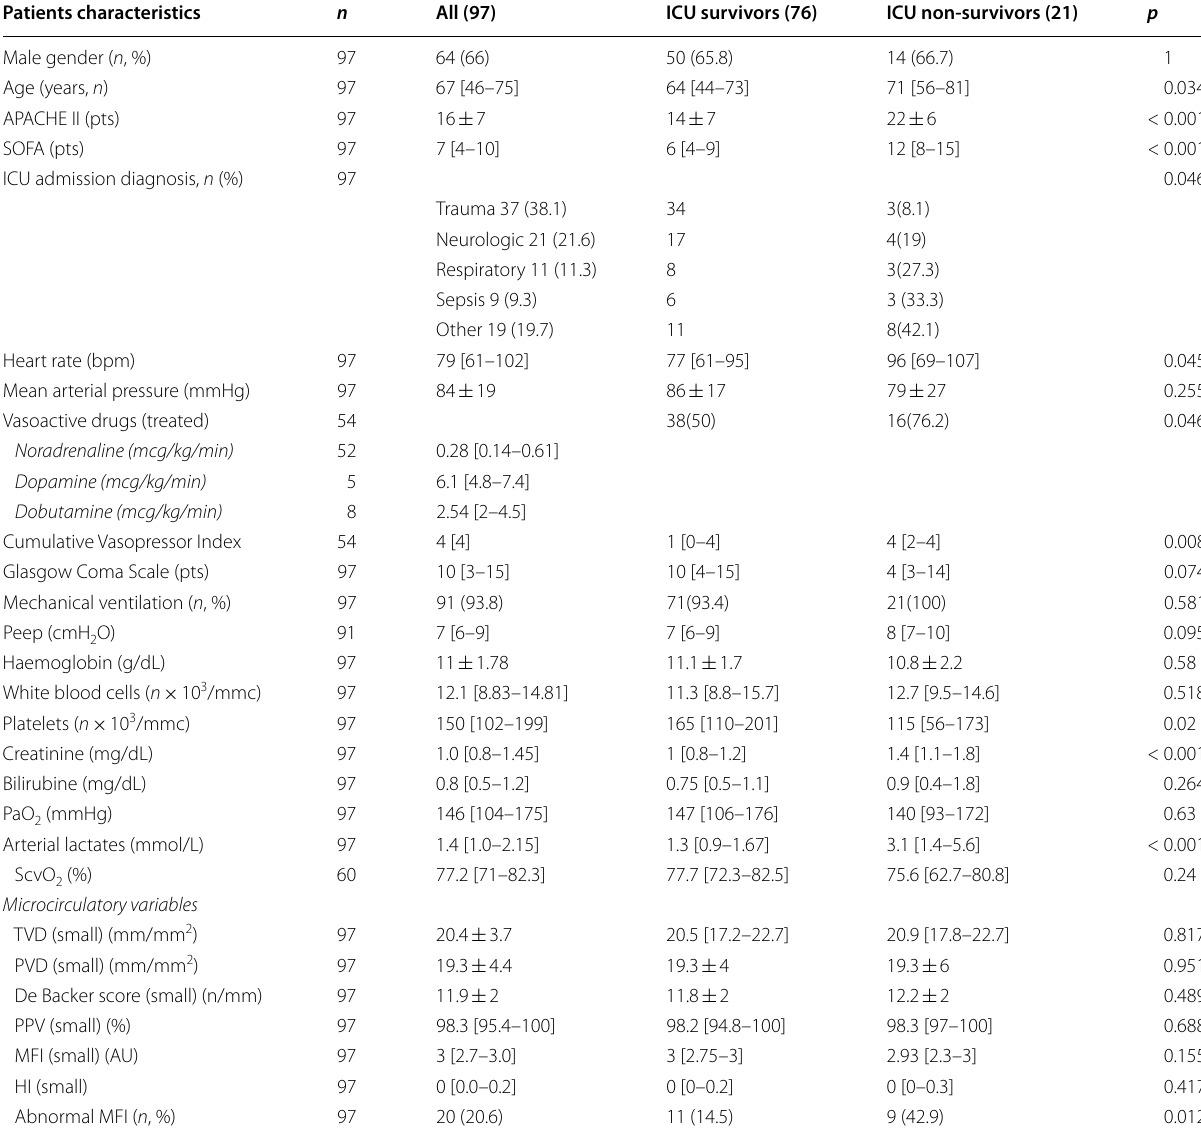
Table 1 Baseline characteristics and comparison between ICU survivors versus